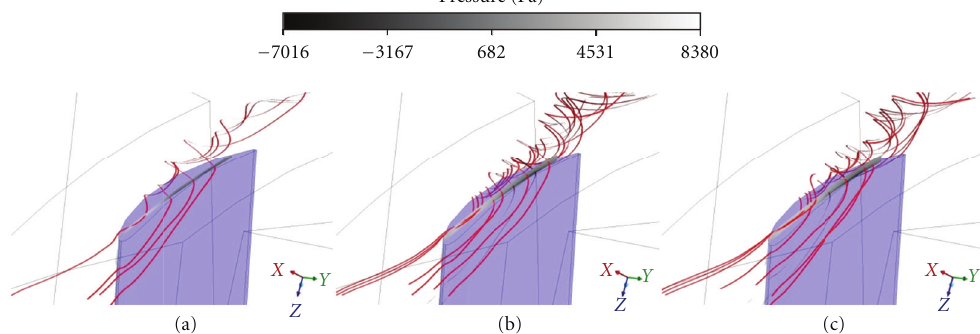
Figure 13: Streams of fluid crossing the gap between the top of the blade and the casing for the case of (a) 0.5 mm gap, (b) 1.0mm gap and (c) 1.5 mm gap. Pressure distribution in the longitudinal plane is also